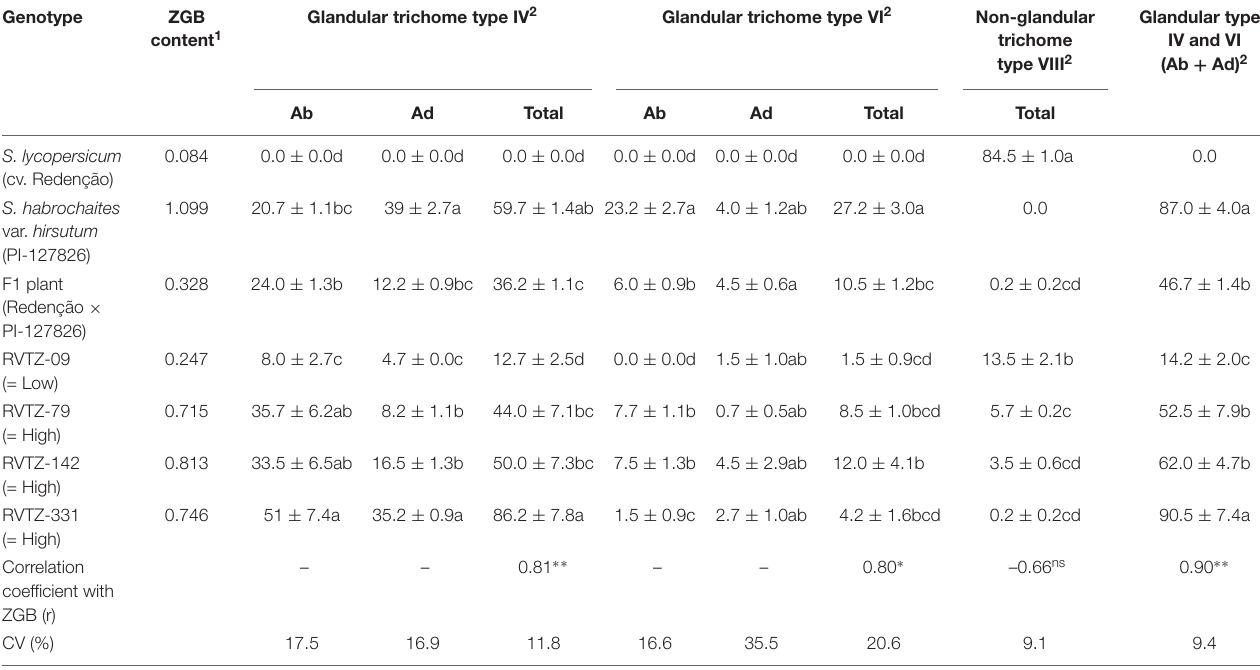
TABLE 1 | Zingiberene content (ZGB) and mean number ( ± SE) of glandular (types IV and VI) and non-glandular (type VIII) trichomes per mm 2 present on abaxial (Ab) and on adaxial (Ad) surfaces of leaflets obtained from different tomato genotypes.